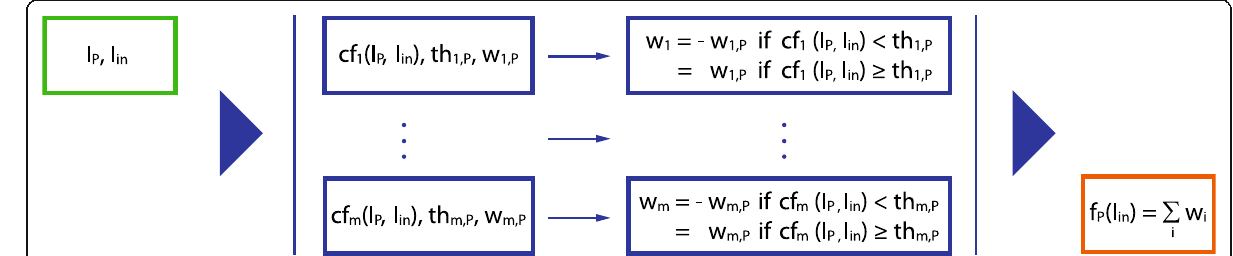
Fig. 8 Schematic representation of the use of comparison functions (Fig. 6). I P : image of prototype P (together with its metadata). I in : any image to be classified. m : number of comparison functions given in LadeCA. cf i : comparison function i . th i,P : threshold of comparison function cf i when used with prototype P . w i,P : weighting of the comparison function cf i when used with prototype P . w i : result of the comparison function cf i applied to images I in and I P . f P : classification function of prototype